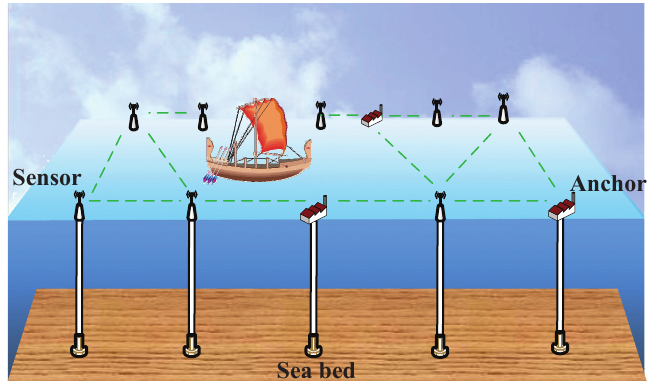
Figure 1. Network